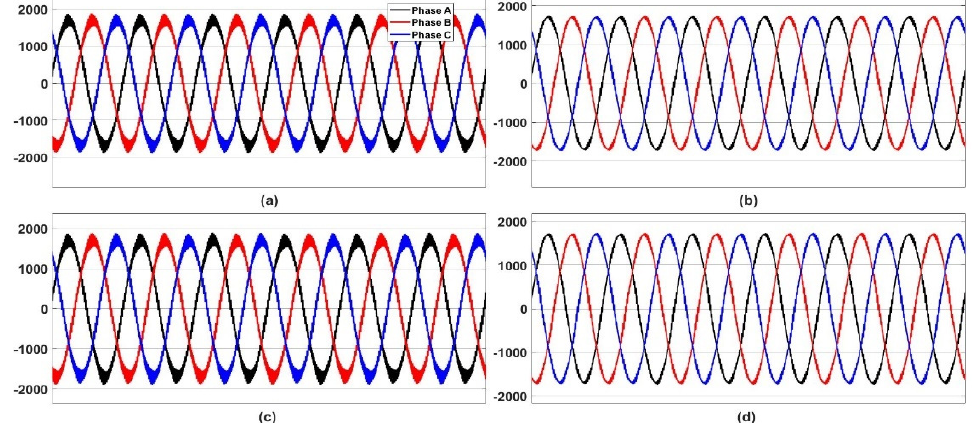
Figure 14. Three-phase pcc currents in the case of ( a ) 2L- αβ , ( b ) 3L- αβ , ( c ) 2L-dq and ( d ) 3L-dq.